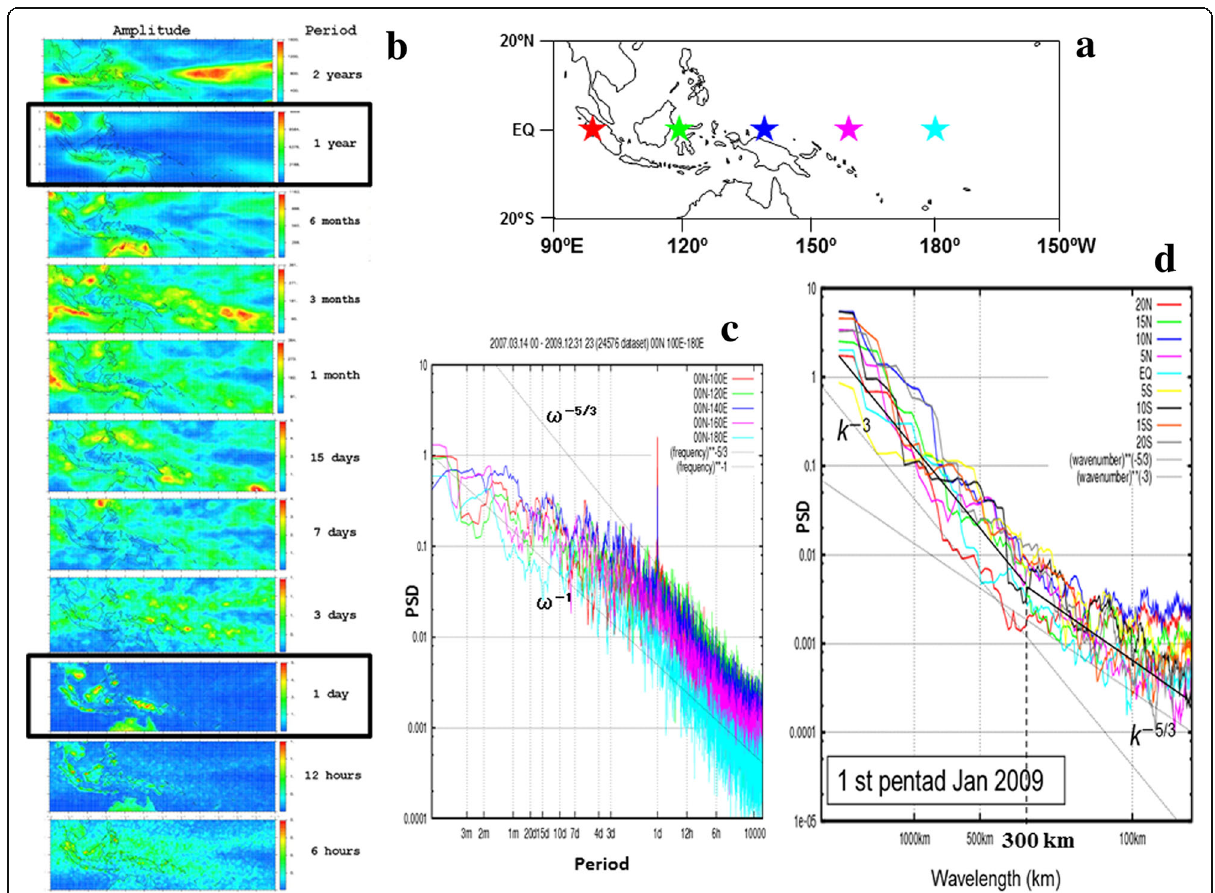
Fig. 7 Spectral analysis of 14-year (1996 – 2009) hourly GMS − OLR cloud top temperature for the region a (Yamanaka 2016). Frequency spectra are b plotted geographically for 6 h to 2-year components and are shown c for five locations at every 20° longitude from 100° to 180° E along the equator (indicated by stars in a ). d Zonal wavenumber spectra for the 90° E – 150° W longitude range at every 5° latitude around the